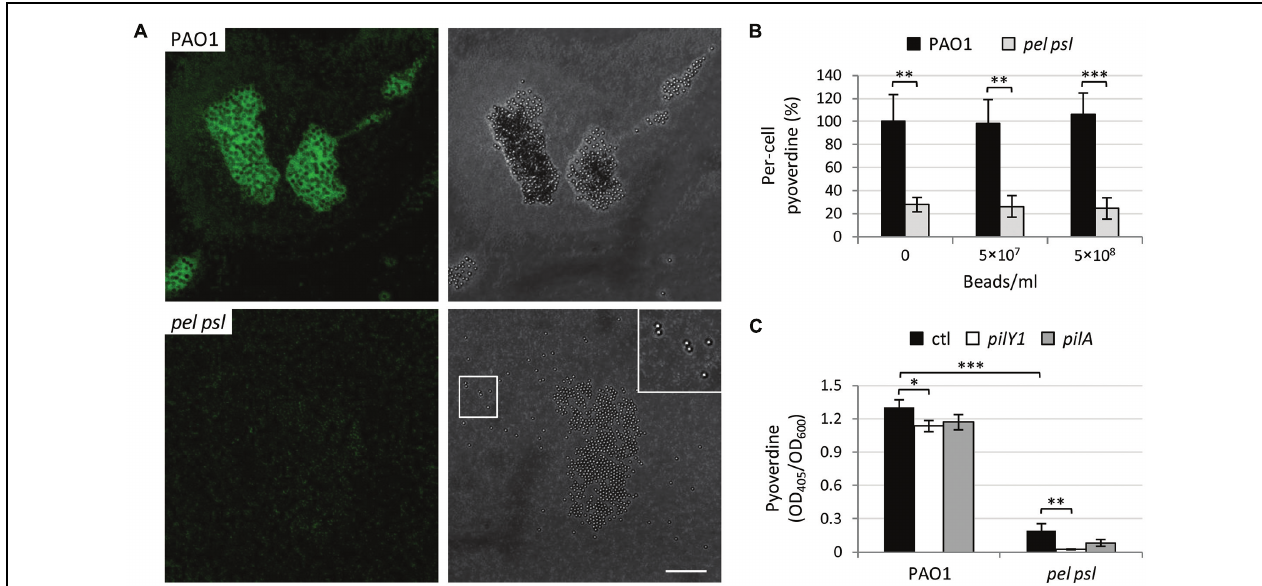
FIGURE 5 | Aggregation does not stimulate pyoverdine production thorough non-specific physical contacts or the mechanosensors PilY1 and type IV pili. (A) Confocal microscopy images of P. aeruginosa PAO1 and pel psl cells harboring the GFP-expressing vector pMMG cultured in TSBD in the presence of 5 × 10 8 polystyrene beads/ml. Images are representative of several micrographs showing similar results. Bar: 30 μ m. The inset is a 2 × magnification of the highlighted area. (B) Pyoverdine production by P. aeruginosa PAO1 and pel psl in the presence or in the absence of 3- μ m size polystyrene beads (5 × 10 7 or 5 × 10 8 beads/ml),